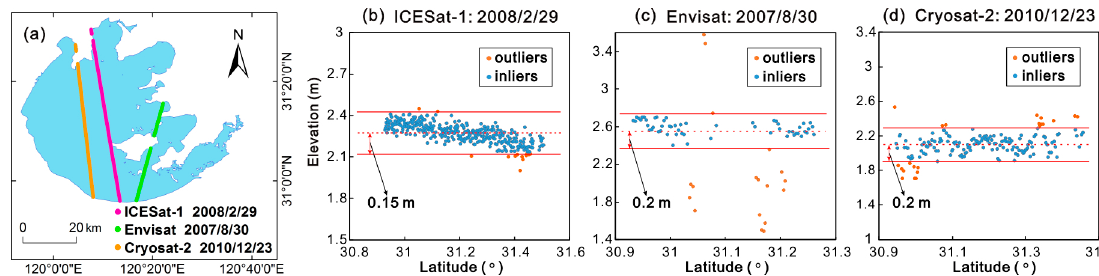
Figure 3. The example of outlier removal. ( a ) The location of ground tracks of three satellite altimeters, and outlier removal for ( b ) laser and ( c , d ) radar satellite altimetry data.